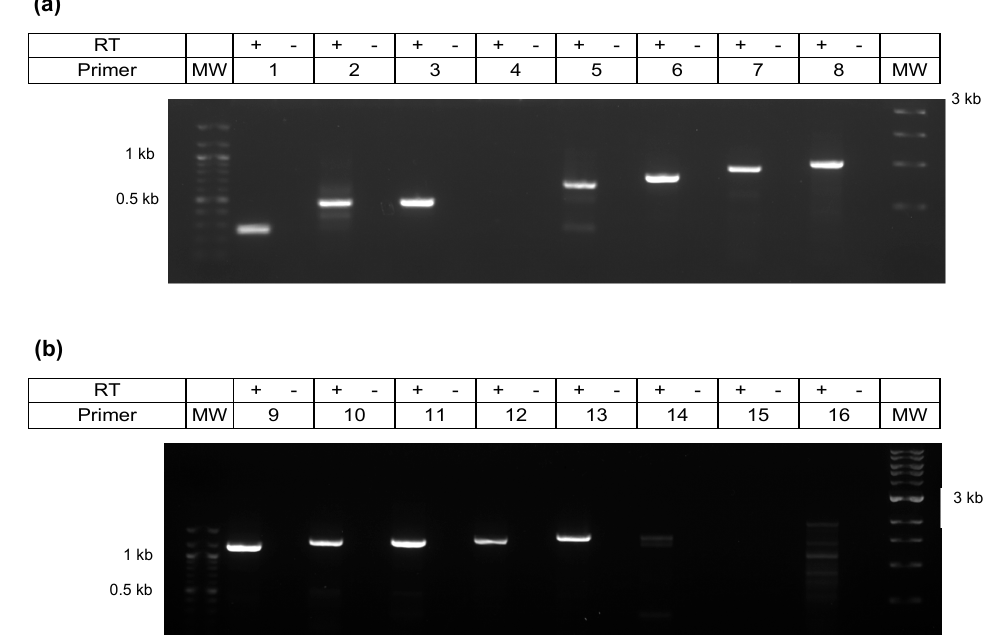
Figure 5. Primer walking for elucidation of ORF-A 3 ′ terminus. Strand-specific RT-PCR of BoHV-1.1-